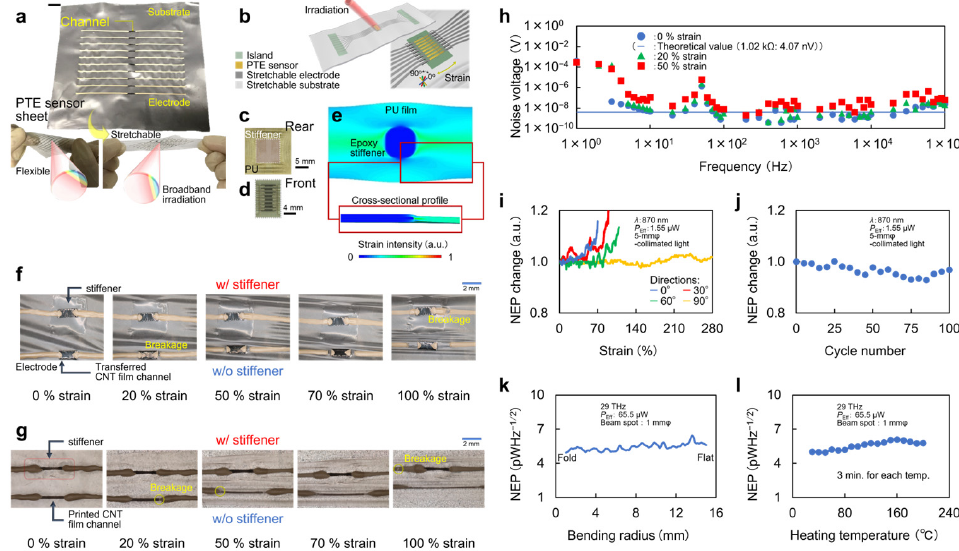
Figure 5. Mechanical and thermal durability and the associated optical stability of the CNT-film- based PTE sensor sheet. ( a ) Photograph and ( b ) schematic of the device. ( c ) Photograph of the rigid-soft patterning. ( d ) Photograph of the CNT film channel located above the partial stiffener. ( e ) FEM simulation of strain distribution on the device. ( f ) Comparisons of the device stretchability with and without the partial rigid stiffener with transferred CNT film channels and ( g ) printed CNT film channels. ( h ) Stability of the device thermal noise against strains. ( i ) Changes in NEP values of the device against multiaxial strains. ( j ) Stability of the device’s NEP values against the repetitive stretching. ( k ) Stability of the device’s NEP values in each bending radius during the sheet folding. ( l ) Thermal stability of the device’s NEP values. ( a – j ): Reproduced with permission from [26] Copyright 2022, the authors, published by American Association for the Advancement of Science. ( k , l ): Reproduced with permission from [24] Copyright 2021, the authors, published by Wiley-VCH.